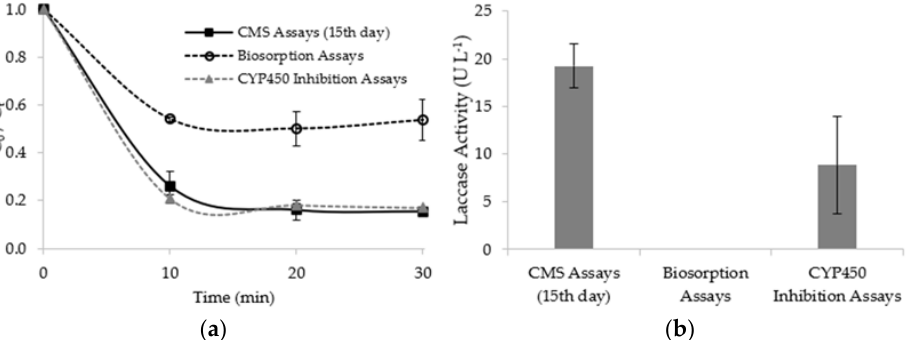
Figure 4. ( a ) Progression curves of residual fluoxetine concentration over time and ( b ) mean laccase activity of the CMS (after 15 days of storage), biosorption, and cytochrome P450 (CYP450) inhibition assays.